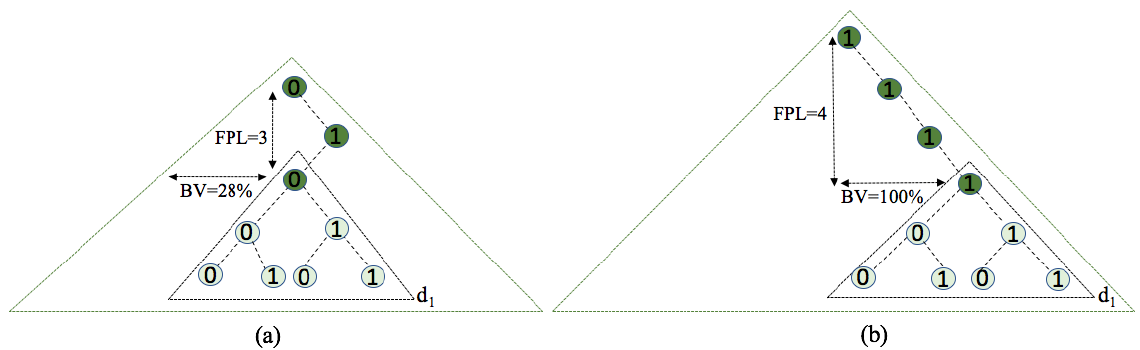
Figure 5. Examples of tag ID distribution types for d 1 and adjustable values: ( a ) FPL = 3; BV = 28%; ( b ) FPL = 4; BV =